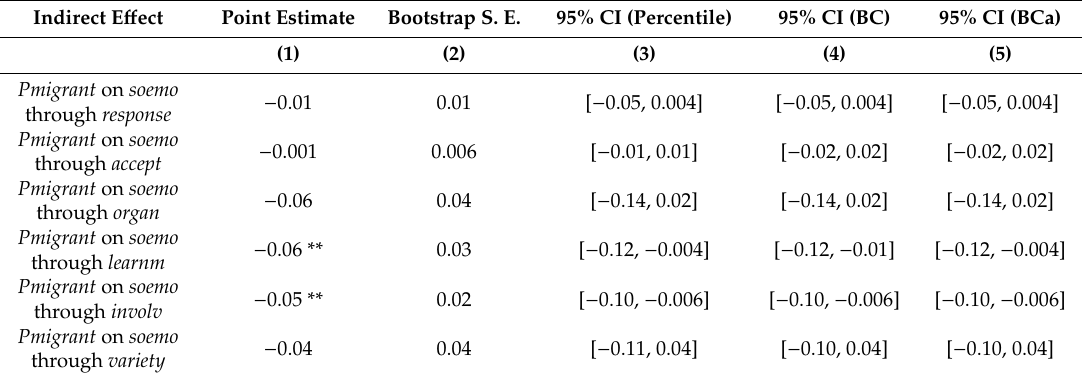
Table 7. Estimates of indirect e ff ects of parental migration on social-emotional development through di ff erent dimensions of home